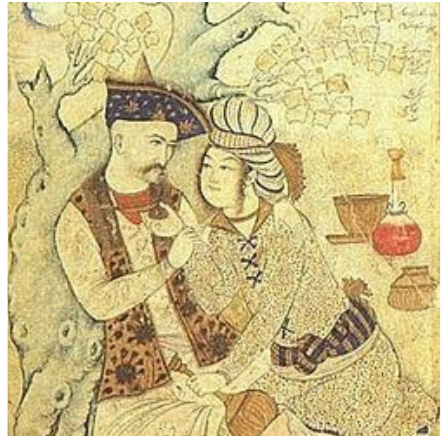
Figure 2. The illustration depicts Shah Abbas I of Persia and his page boy interacting and sharing wine, circa 1627. The imagery is soft and intimate as the page holds the wine flask erect towards the Shah’s crotch and almost embraces him. Source: Public domain image via https://www.queerarthistory.com/love-between-men/muhammad-qasim-shah-abbas-i-with-a-page/ (accessed on 14 March 2022).